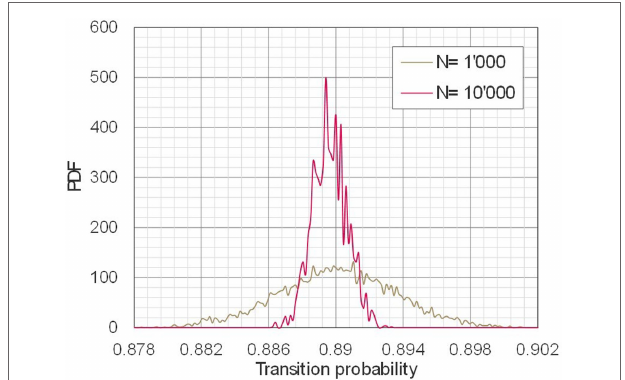
FIGURE 7 | Posterior distributions of π 11(1).